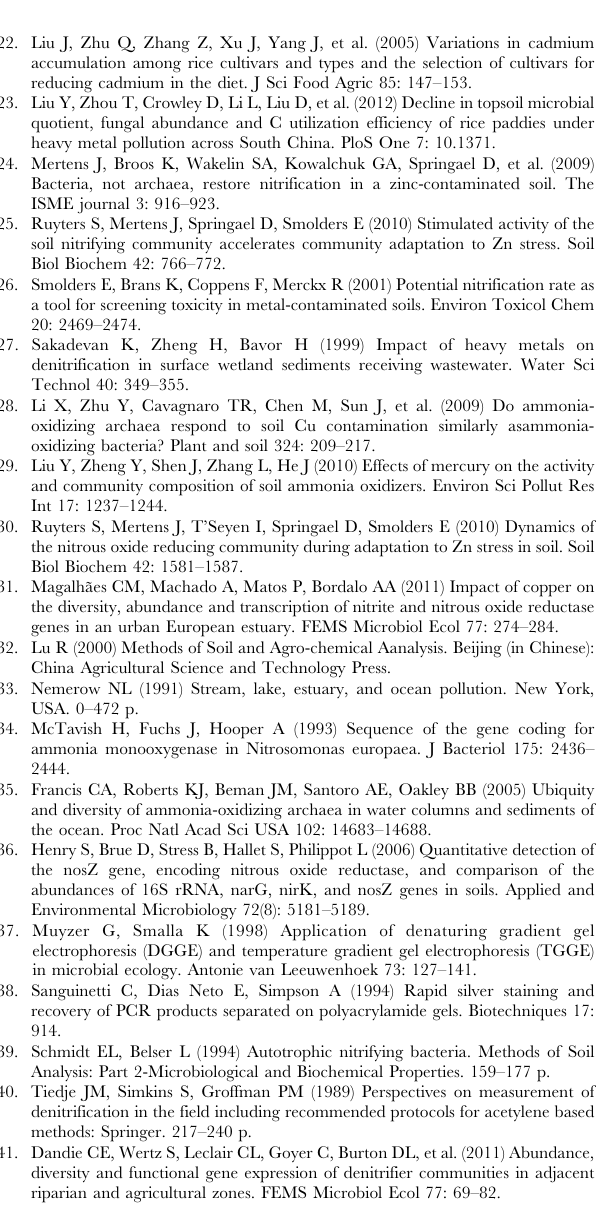
Figure S1 Principal component analysis (PCA) of DGGE profiles of AOB (a), AOA (b) and nirK (c) gene fragment from the soil samples at the two sites. DX-B and DBS-B, background soil from site DX and DBS; DX-P and DBS-P, polluted soil from site DX and DBS. Similar symbols with same color in PCA plot indicate the replicate samples. (TIFF) Figure S2 DGGE profiles of AOB (A), AOA (B) and nirK (C) gene fragment from the soil samples at the two sites. M: 100 bp Marker. DX-B and DBS-B, background soil from site DX and DBS; DX-P and DBS-P, polluted soil from site DX and